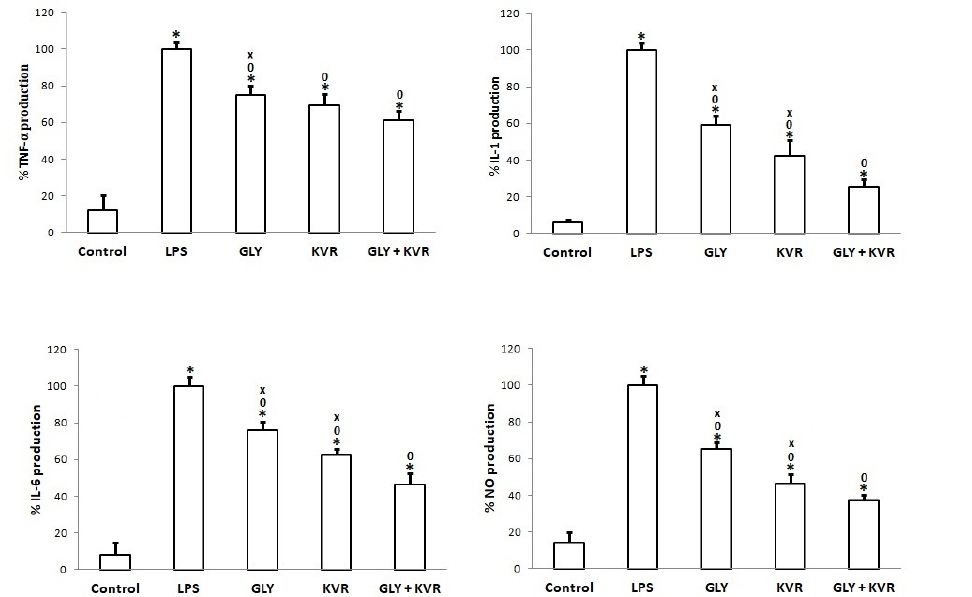
Figure 3. Effect of glycine and kolaviron on lipopolysacharide (LPS)-induced production of cytokines and nitric oxide (NO) in U937-derived macrophages LPS, transformed cells treated with 1 µg/ml Lipopolysaccaride only; GLY, transformed cells supplemented with Glycine (300 µM) before exposure to Lipopolysaccharide (1 µg/ml); KVR, transformed cells supplemented with Kolaviron (25 µg/ml before exposure to Lipopolysaccharide (1 µg/ml); GLY + KVR, transformed cells supplemented with both Glycine and Kolaviron (300 µM GLY + 25 µg/ml KVR) before exposure to Lipopolysaccharide. Each bar represents mean ± S.E.M of six replicates expressed as % viability in comparison to LPS. *Significantly different from control; o Significantly different from LPS and x Significantly different from GLY + KVR. p <